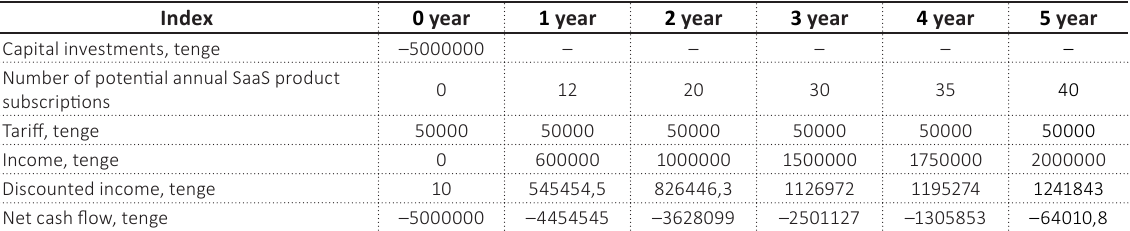
Table 9. Calculation of the payback period of the SaaS product “3D-quarry” (the cost of an annual subscription is 60,000 tenge)